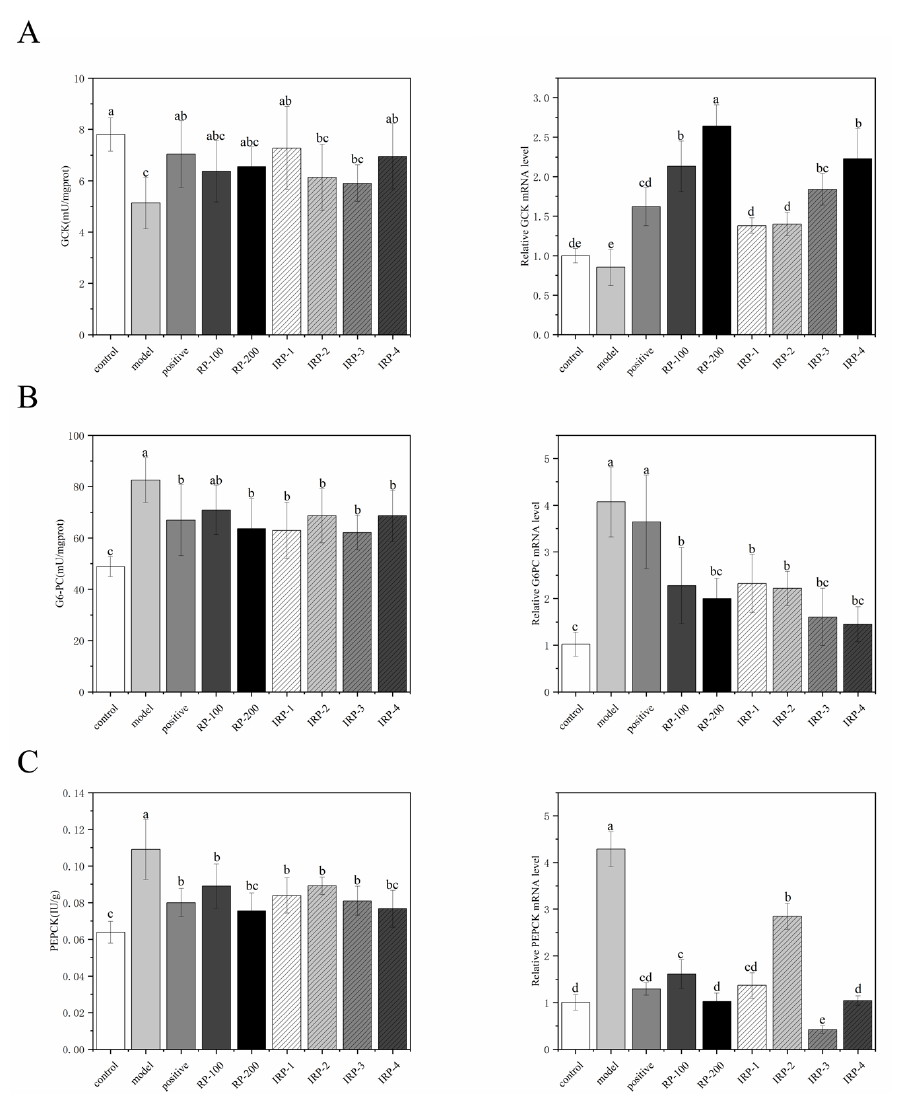
Figure 4. Effects of RP and IRP 1–4 on hepatic gluconeogenesis in T2DM mice. RP and IRP 1–4 increased the activities of GCK ( A ) and decreased the activities of G6PC ( B ) and PEPCK ( C ). RP and IRP 1–4 increased the relative mRNA levels of GCK ( A ) and reduced the relative mRNA levels of G6PC ( B ), and PEPCK ( C ). All data were expressed as the means ± SD ( n = 6). Different letters indicate a significant difference ( p <